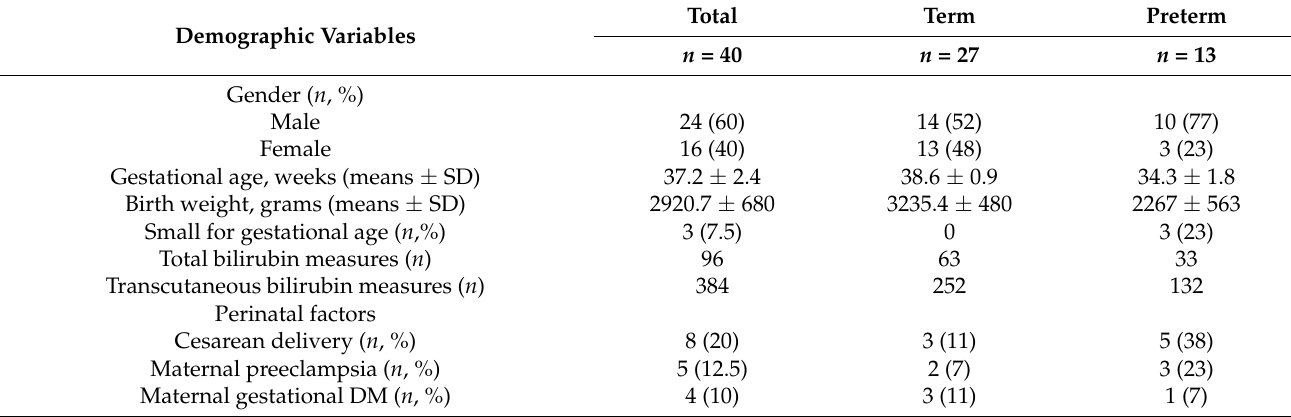
Table 1. Clinical characteristics of our study population.